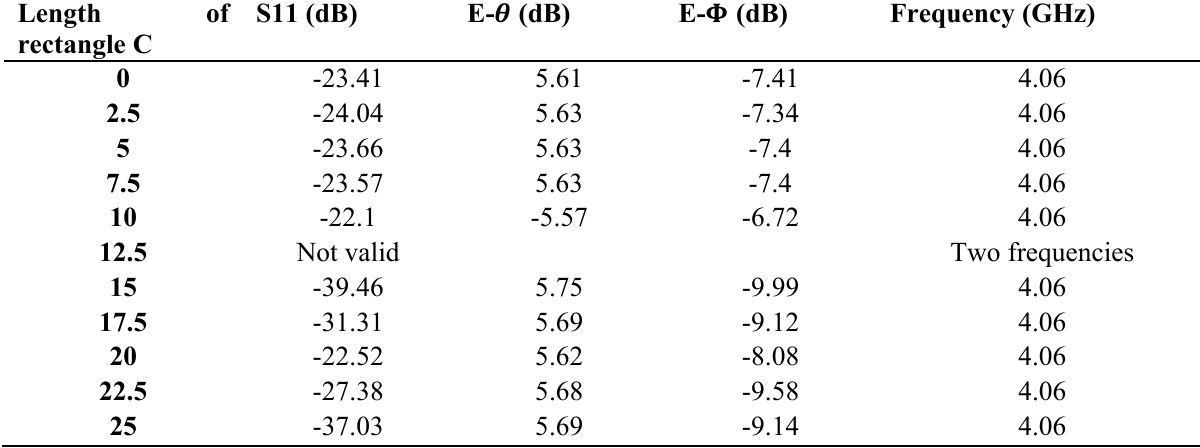
Table 3. Results of third parametric study